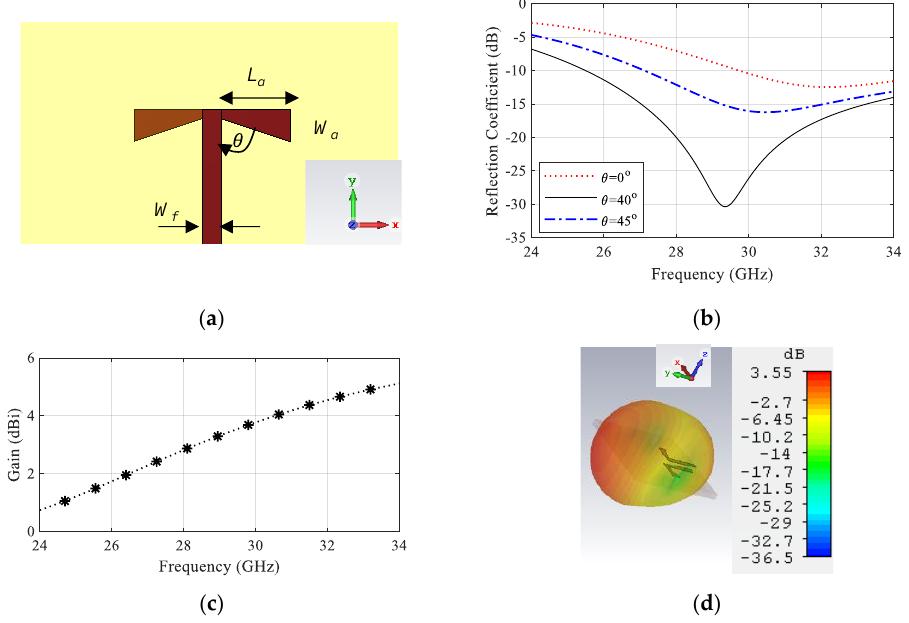
Figure 3. Geometry of the semi − triangular DA and its results. ( a ) Antenna configuration. ( b ) Antenna reflection coefficient. ( c ) Antenna gain versus frequency. ( d ) Antenna 3D radiation pattern at 29.5 GHz.